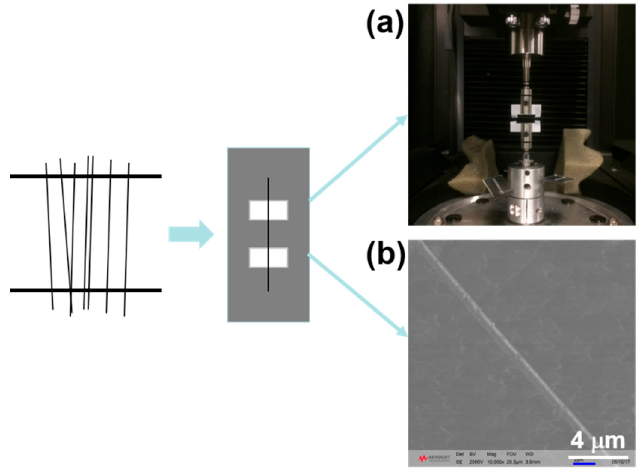
Figure 6. A schematic diagram for the preparation of single fiber samples. ( a ) Setup for the uniaxial tensile testing of a single electrospun fiber; ( b ) SEM morphology of a single electrospun fiber.